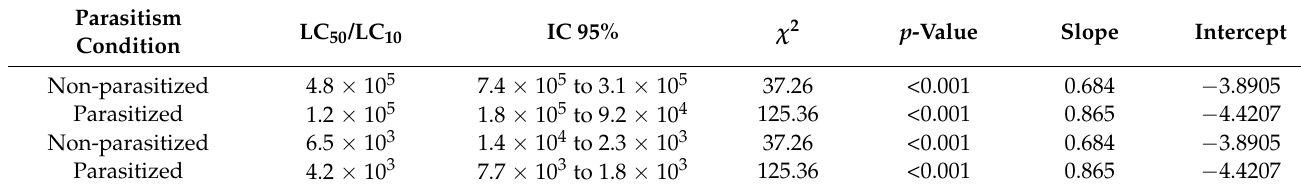
Table 2. Pathogenicity of Metarhizium robertsii V3-160 to 7 d-old, parasitizedlarvae of Anastrepha ludens parasitized by Diachasmimorpha longicaudata , via topical